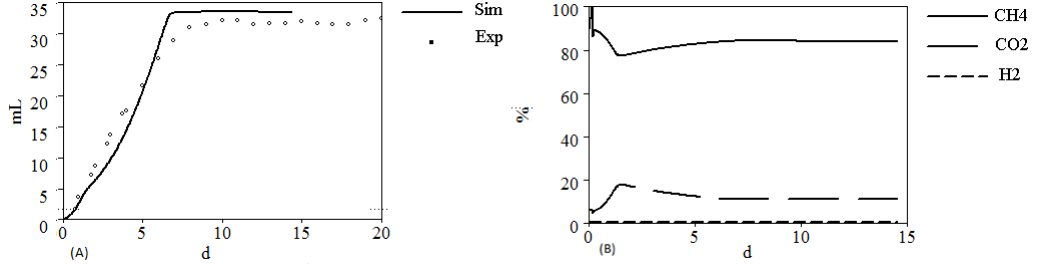
Figure 2: Biogas accumulation (A) and partial gas pressure (B) simulated by the extended model